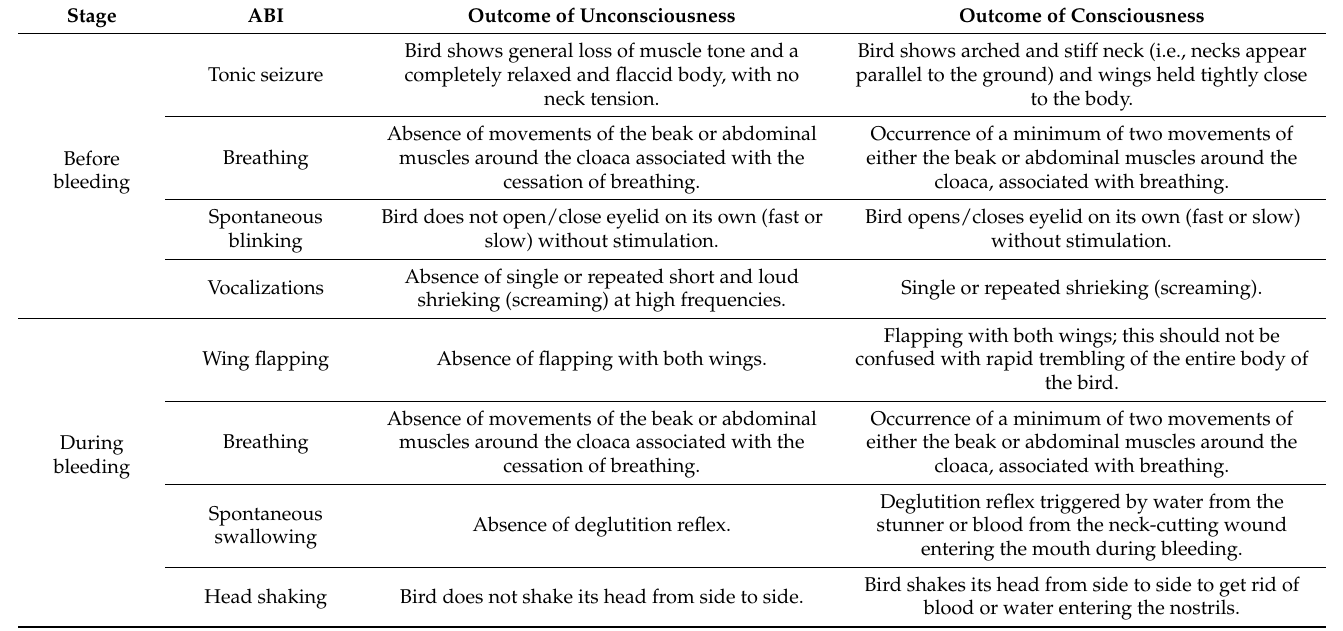
Table 3. Animal-based indicator (ABI) assessments and descriptions of the outcomes of unconscious- ness and consciousness in broilers stunned by waterbath in two different stages: before and during bleeding. Adapted from EFSA